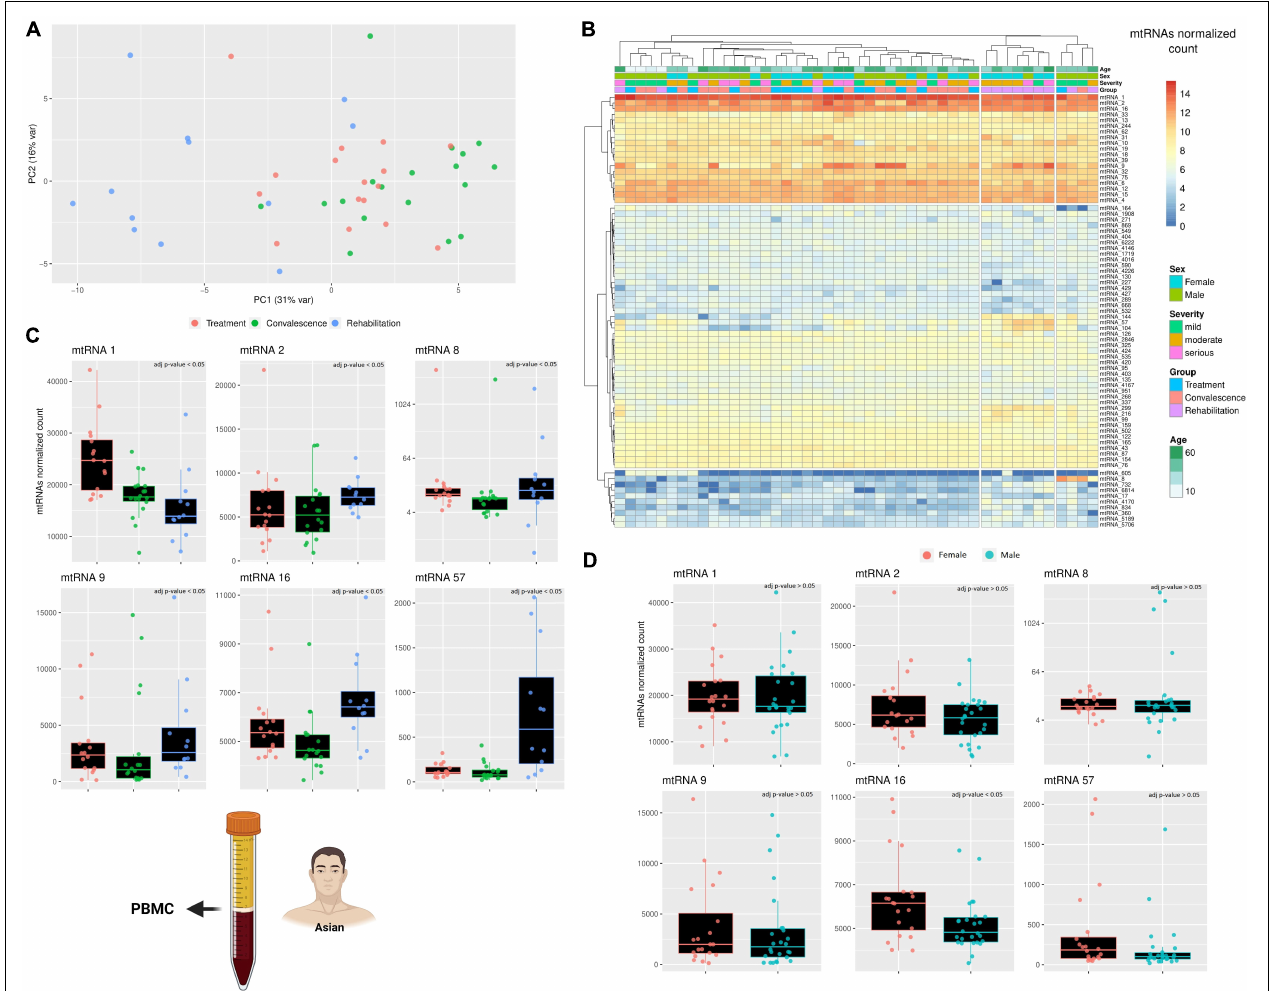
FIGURE 2 | A comparison across three clinical stages of small RNAs expression. (A) The PCA shows how the differences in the small mitochondrial RNAs expression cluster the patients during the rehabilitation stages away from the other two clinical stages. This effect is evident already on the PC1, suggesting that only a small number of small mitochondrial RNAs is driving this effect. The variability of each principal component is in the axis label. (B) The heatmap compare the expression of small RNAs encoded on the mitochondrial genome. The rows represent clusters of small RNAs (mtRNAs), while the columns are individuals. Each individual has annotated the severity of the COVID-19 infection and the stage when their blood sample was taken, its age, and its sex (male/female). The different level of expression, ranging from blue to red. (C,D) The barplot compare the expression of several mtRNAs that are differentially transcribed across the three clinical stages (C) and across sexes (D) . Each datapoint in a single clinical stage (e.g., Rehabilitation) represent a different patient, furthermore, the patients are the same across the three clinical stages. Full stats can be found in Supplementary Table 1 . Due to the presence of an outlier with very high expression, only mtRNA8 has its Y-axis in Log scale. The icons in the figure on the left-side highlights from which population and type of sample the data are generated. The icons have been made using